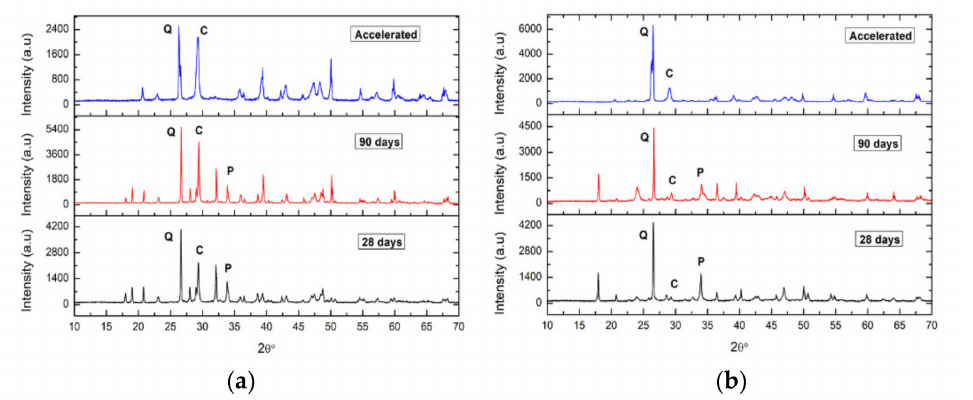
Figure 12. Graph that represents the evolution of carbonation over time in the area closest to the surface of a mortar from Group In ( a ). Graph that represents the evolution of carbonation over time in the area closest to the surface of a Group IIn mortar. ( b ). C: Calcite, P: Portlandite, Q: